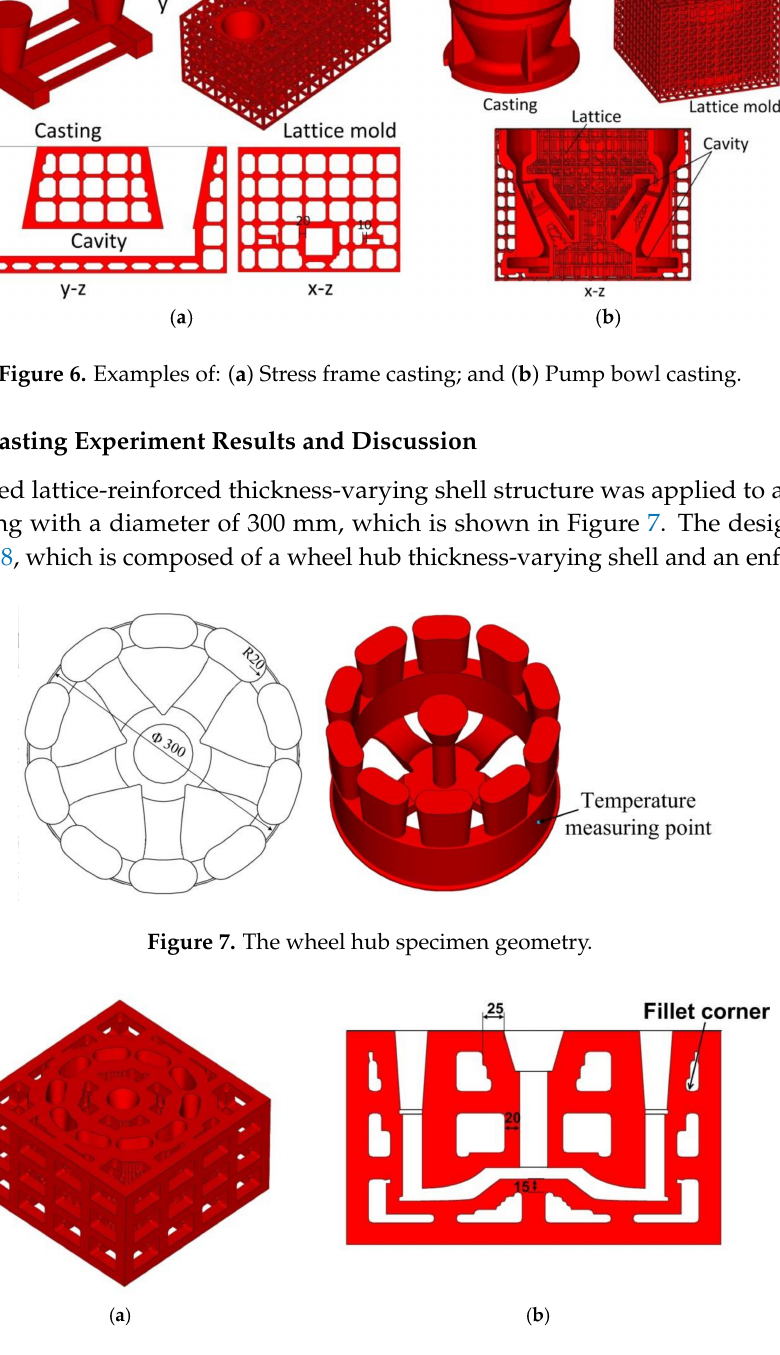
Figure 8. The generated lattice shell mold: ( a ) Lattice shell mold; and ( b ) Cross-section slice (Unit: